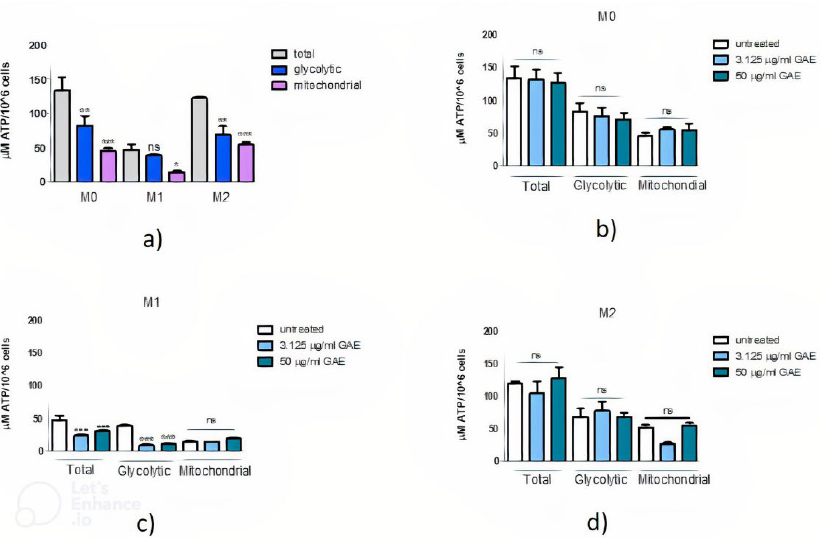
Figure 8. Effect of phenolic sumac extract on ATP production in M0, M1 and M2 macrophages. After 24 h treatment the production of total, glycolytic and mitochondrial ATP levels, expressed as μM ATP/10 6 cells, was measured. Panel ( a ) shows ATP levels in M0, M1 and M2 macrophage phenotypes before the treatment with SE. ATP levels after treatment with SE are shown in M0 ( b ), M1 ( c ) and M2 ( d ). All data represent the means of at least 2 replicates ± standard deviation. The analysis of variance was carried out using the One-way ANOVA test followed by the Tukey’s Multiple Comparison Test; * p < 0.05, ** p < 0.01, *** p < 0.001 were considered significant (untreated vs. treated samples in different conditions). GAE: gallic acid